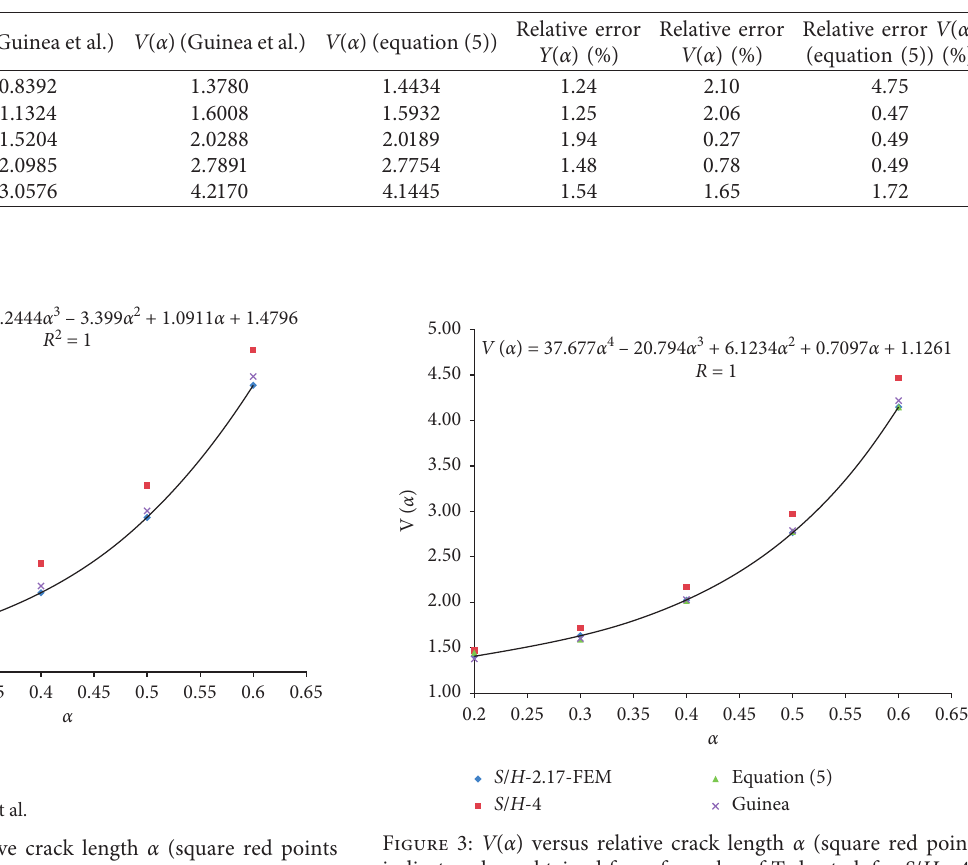
Table 2: Y ( α ) and V ( α ) values obtained by the finite element method compared with values obtained by formulas of Guinea et al. and relative errors.